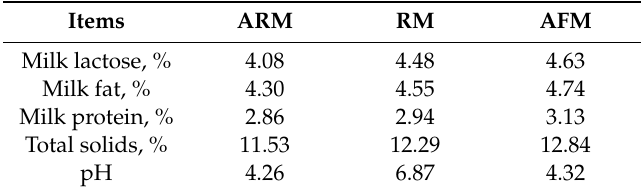
Table 1. Composition of di ff erent types of milk.